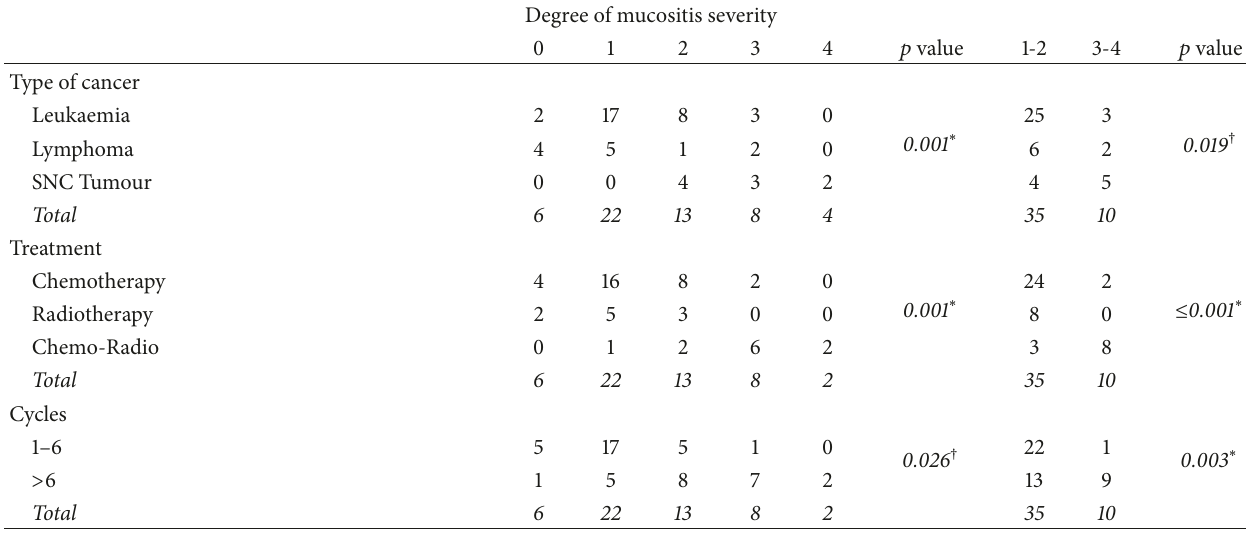
Table 3: Patients according to the degree of mucositis, grouped by severity of mucositis according to the type of cancer, treatment, and number of cycles, expressed as number of